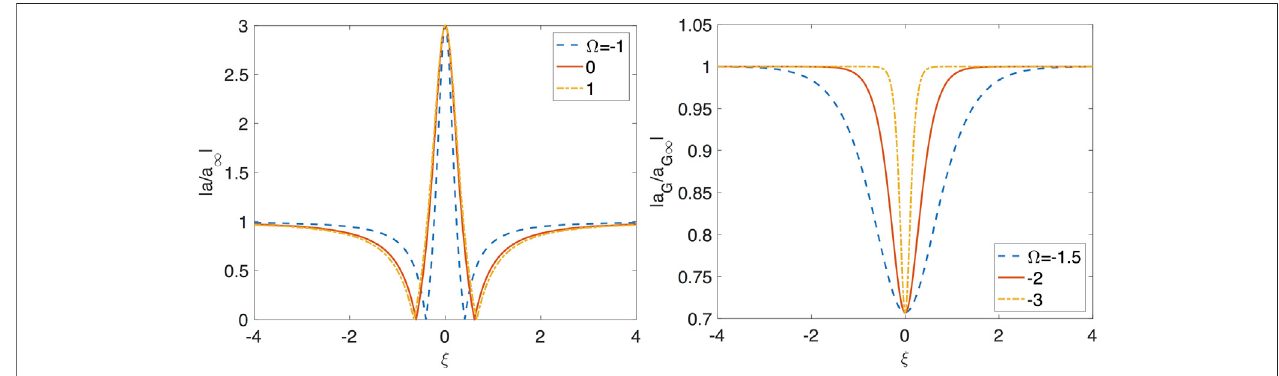
FIGURE 2 | Dimensionless pro fi les of the Peregrine breather (left) and the gray soliton (right) for several values of the vorticity with g (cid:2) 1 and k (cid:2)